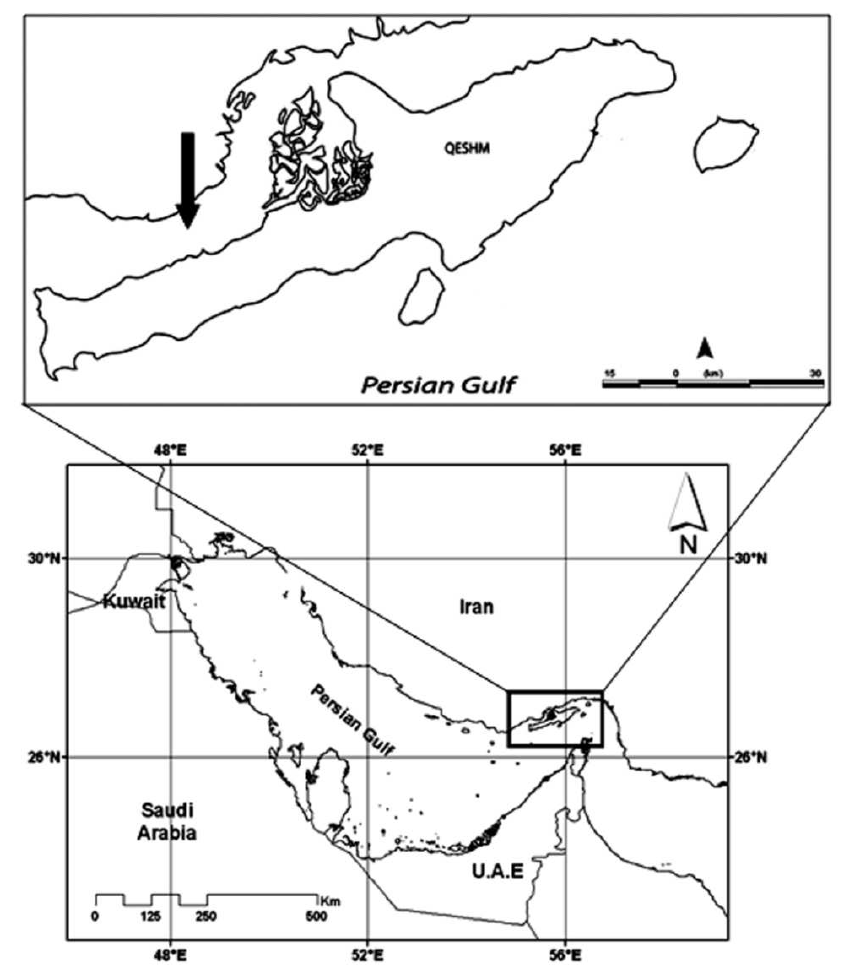
M ATERIALS AND M